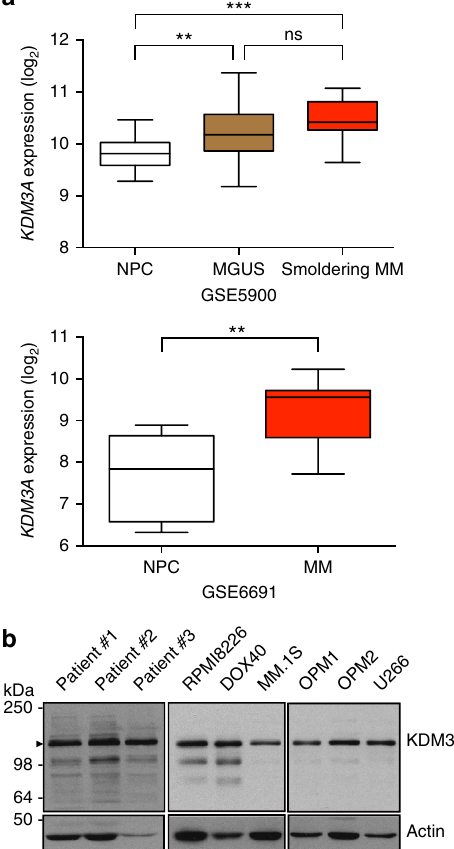
Figure 1 | KDM3A expression in MM cells. ( a ) KDM3A mRNA expression in patient MM samples. Publicly available microarray data sets (GSE5900 and GSE6691) were analysed for mRNA expression of KDM3A in normal plasma cells (NPC), monoclonal gammopathy of undetermined significance (MGUS), smoldering multiple myeloma (Smoldering MM) and MM cells. ** P o 0.01, *** P o 0.001. ns, not significant; analysis of variance (ANOVA) followed by Tukey’s test. ( b ) Immunoblot analysis of KDM3A in patient MM cells and MM cell lines. Arrowhead represents KDM3A. Data are representative of at least two independent experiments, except for patient samples’